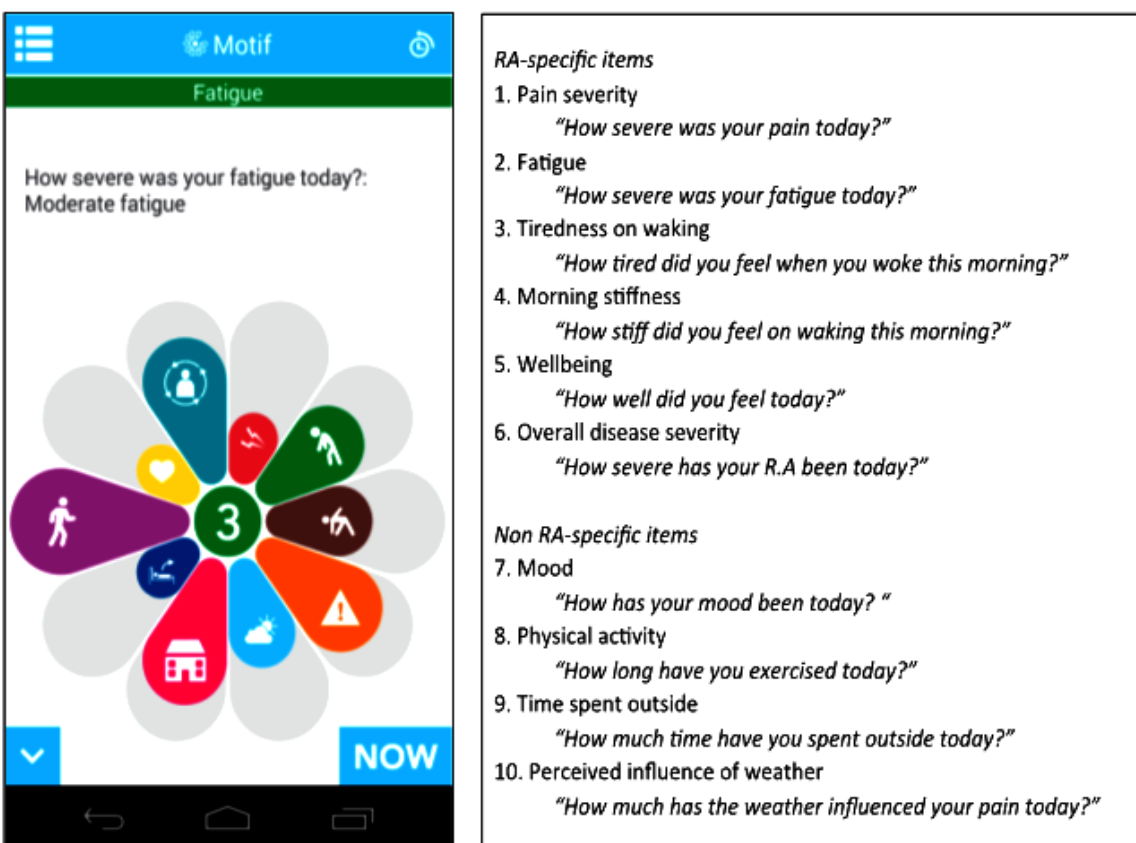
Figure 1. Screenshot of uMotif app and list of data items. Each segment of the motif represents 1 of the 10 questions listed in the box. Participants slide the segment to score their response to the question stem with each question having 5 possible ordinal responses. In the example shown, the participant is responding to the question “How severe was your fatigue today?” with a response of “Moderate fatigue,” selected from options of no fatigue, mild fatigue, moderate fatigue, severe fatigue, and very severe fatigue. RA: rheumatoid